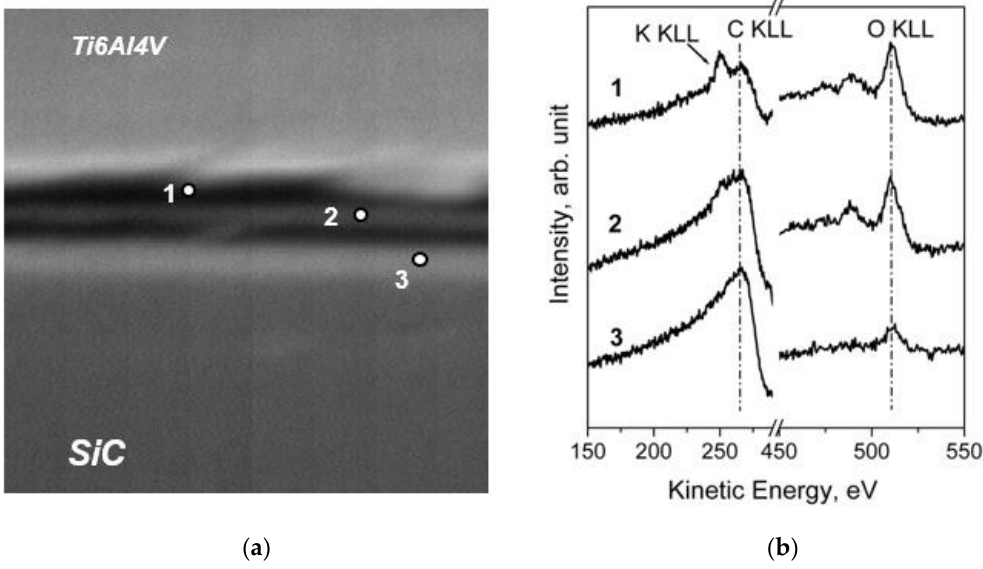
Figure 19. SEM image 80 × 80 µm 2 ( a ) and AES spectra ( b ) acquired on the cross section of Sample 2 across the carbon layer; analysis points are labelled 1, 2 and 3 [29].